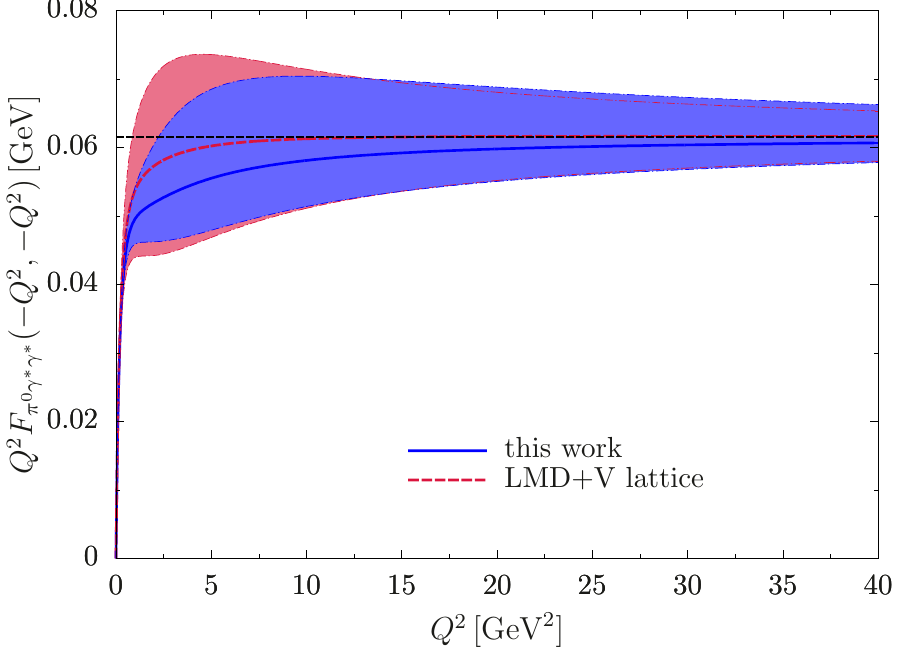
2 ; Q 2 ) (blue solid line with uncertainty band), (cid:25) 0 (cid:13) (cid:3) (cid:13) (cid:3) ( (cid:0) Q (cid:0)